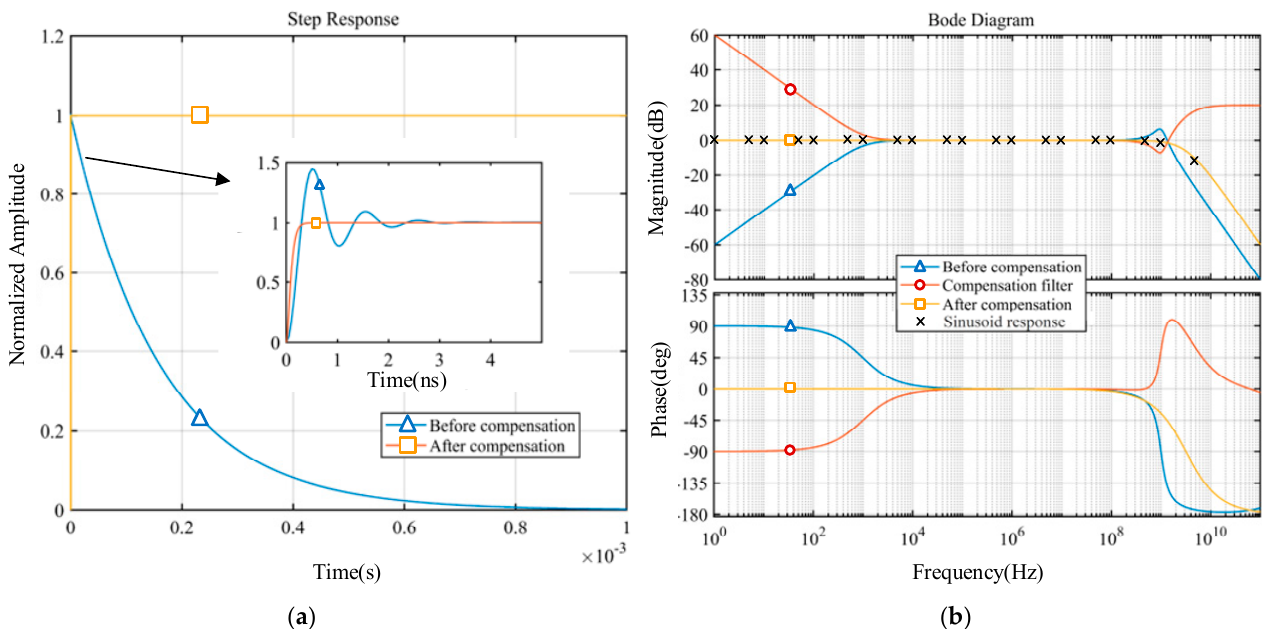
Figure 10. Comparison of the system’s response before and after compensation: ( a ) step response; ( b ) frequency response.